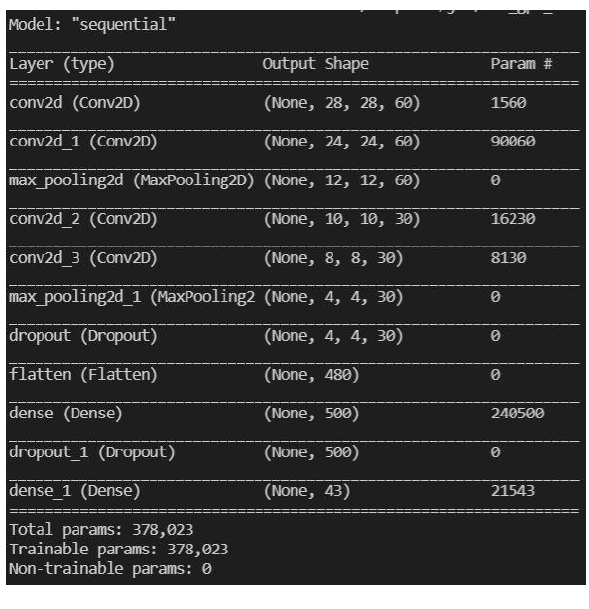
Fig. 11. Summary of CNN Model